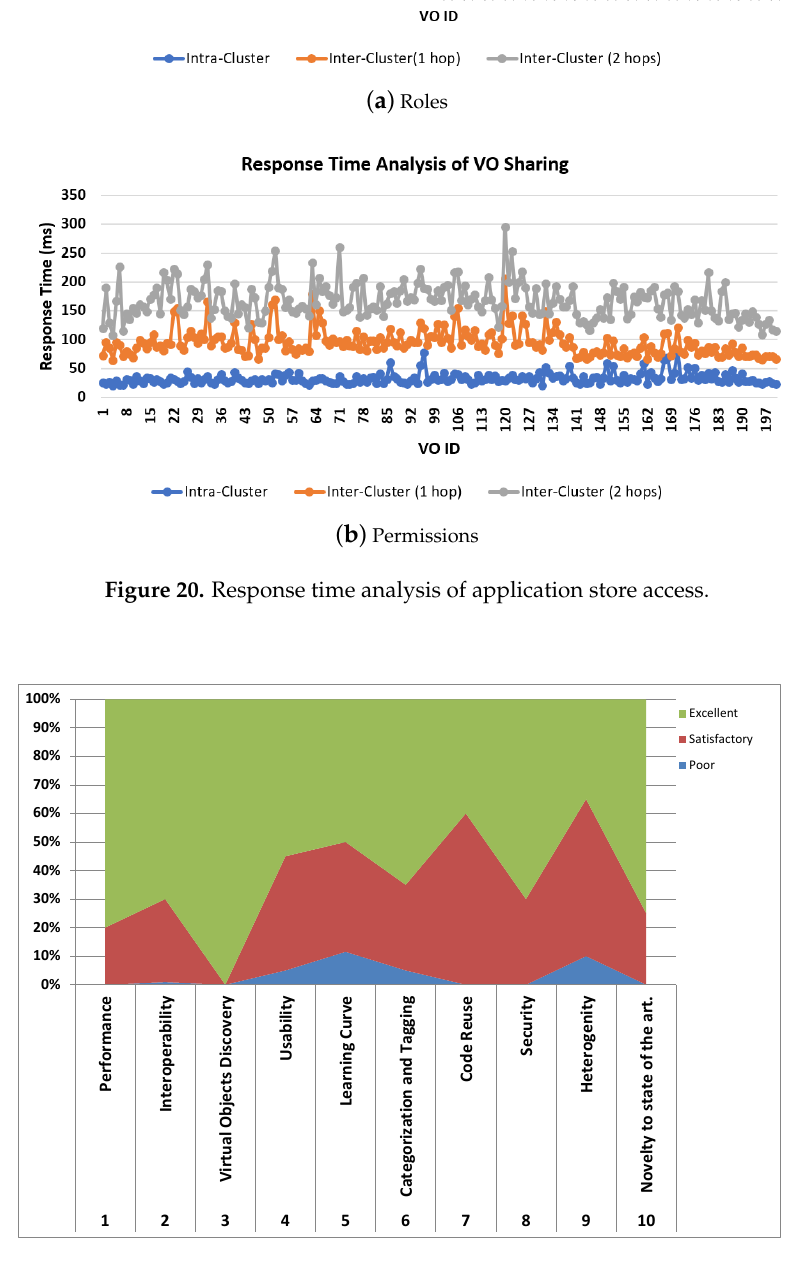
Figure 21. Subjective